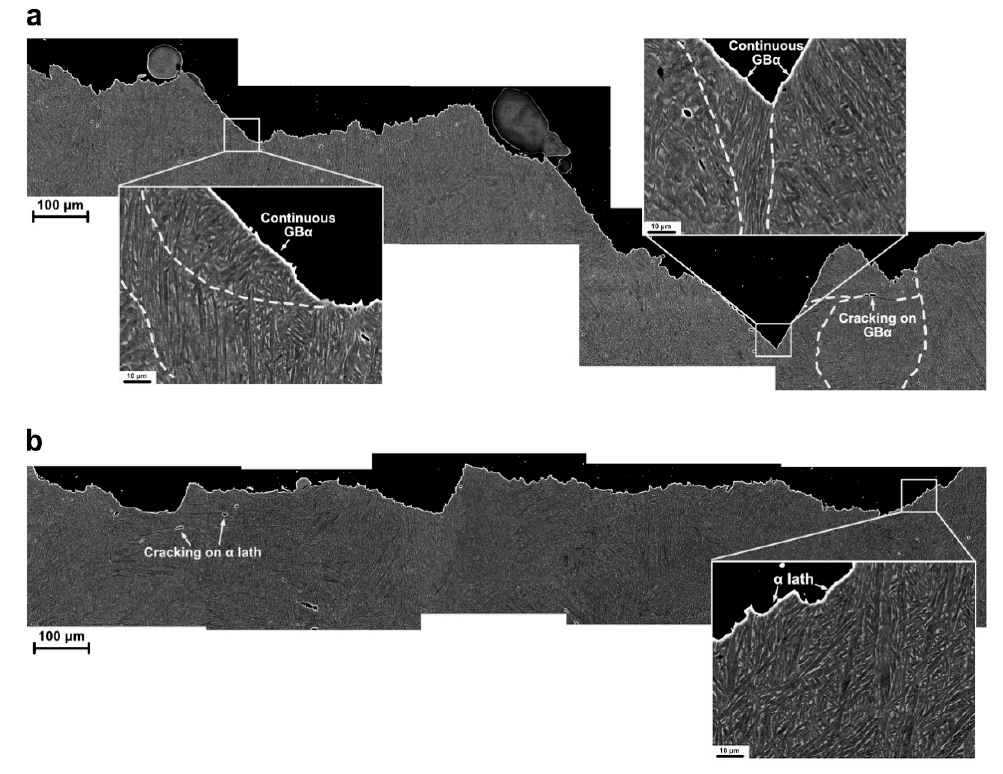
Figure 11. The fracture surface cross-section characterization of SLMed Ti-64 annealed at 850 °C in two directions: ( a ) horizontal direction; ( b ) vertical direction. The prior β grain boundaries were traced with white dot lines.